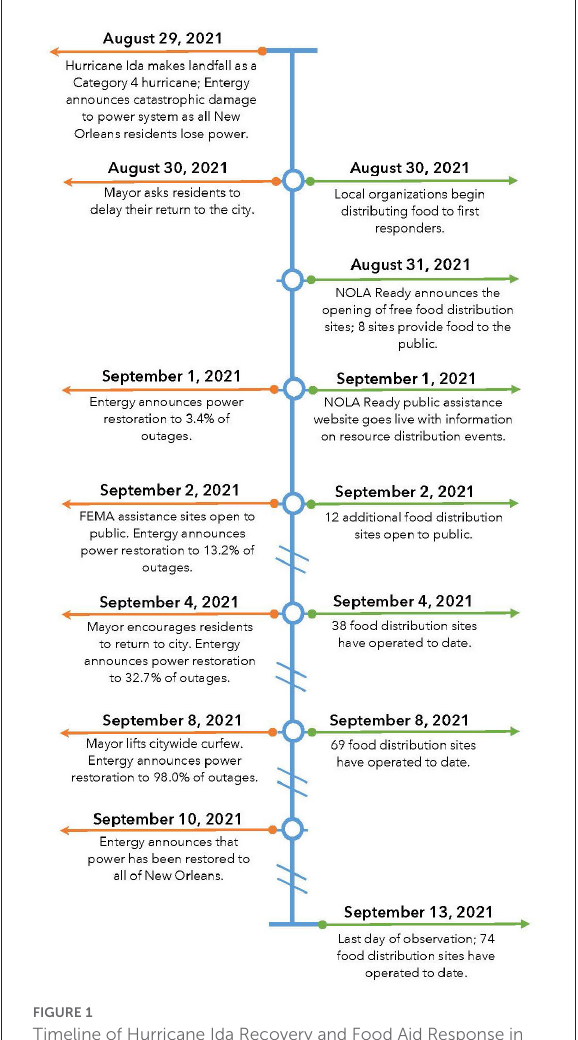
FIGURE1 Timeline of Hurricane Ida Recovery and Food Aid Response in New Orleans, LA between 8/29/21 and 9/13/21. Timeline of events developed by authors. Dates and events presented reflect publicly available information published by Entergy